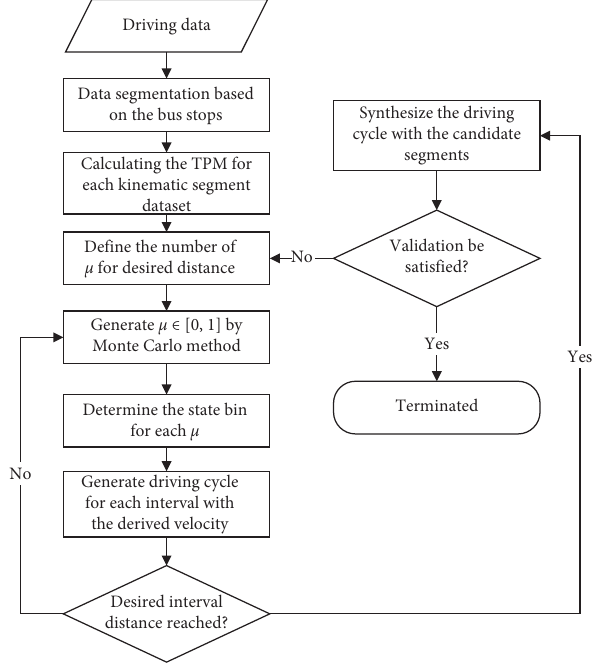
Figure 6: The procedure of a driving cycle synthesis.